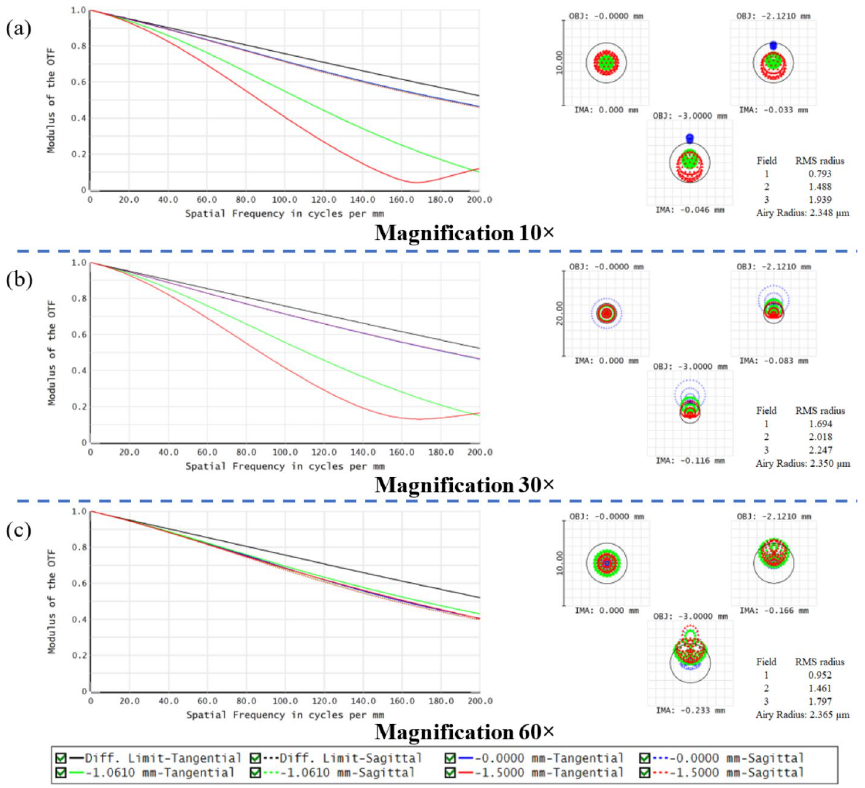
Fig. 4 MTF and spot diagrams of the zoom objective lens at the magnifications of (a) 10 × , (b) 30 × and (c) 60 in the front zoom group is consistent with the angle of incidence in the rear zoom group; (2) the exit pupil of the front zoom group is at the same position as the entrance pupil of the rear zoom group; (3) the aperture angle of the emergent ray in the front zoom group is smaller than the aperture angle of the incident ray in the rear zoom group. These con- ditions ensure that the front and rear zoom groups are stitched together perfectly.